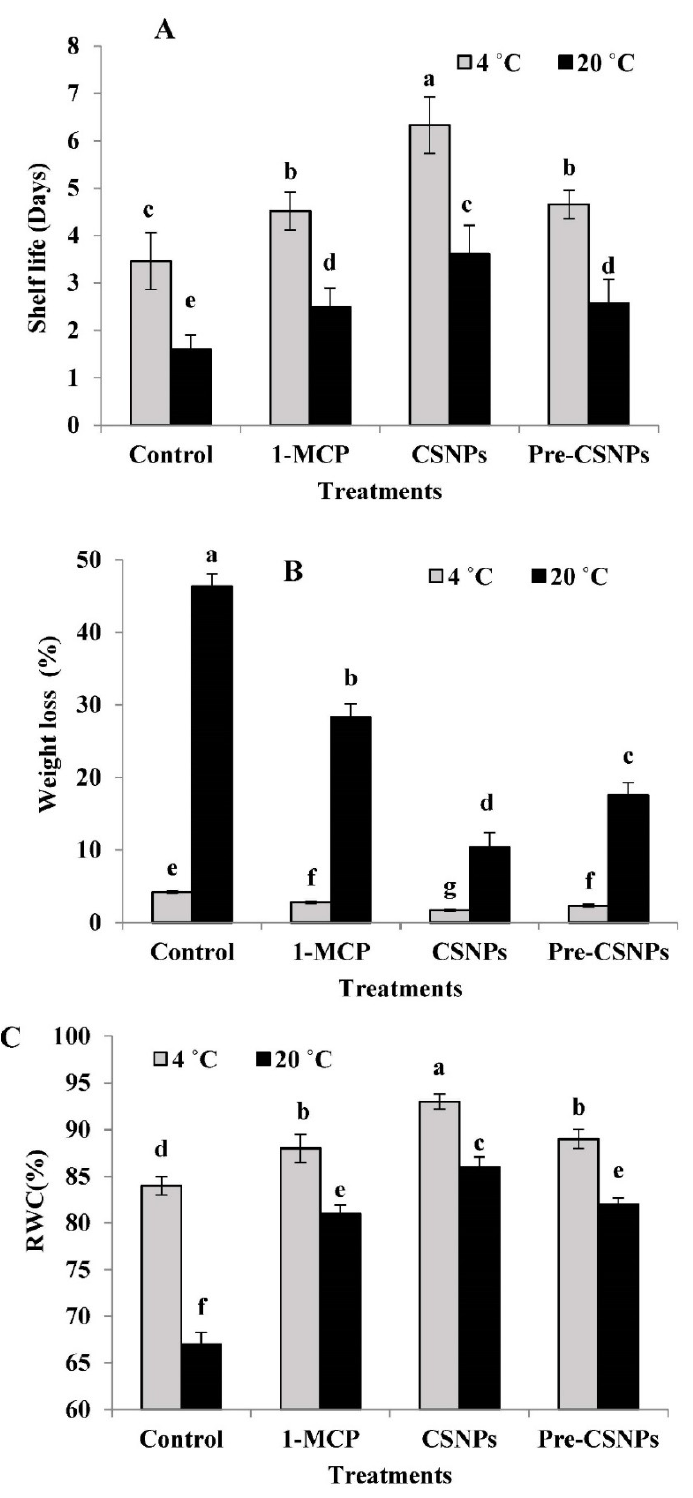
Figure 1. Shelf life ( A ), weight loss ( B ) and relative water content (RWC) ( C ) of damask rose flowers stored at 4 or 20 °C and treated with 1-MCP and pre- and post-chitosan nanoparticles (CSNPs). Values are the means ± SE of two investigations ( n = 8). Columns with different letters are statistically different at p ≤ 0.05.